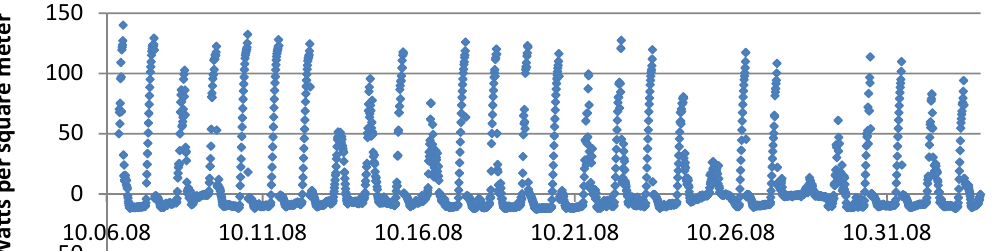
Figure 6. Net “allwave” radiation being absorbed by a four-inch green roof system within our network. The data time interval is 15 minutes. For much of the diurnal cycle, net allwave radiation is negative except for the mid-day hours of peak solar